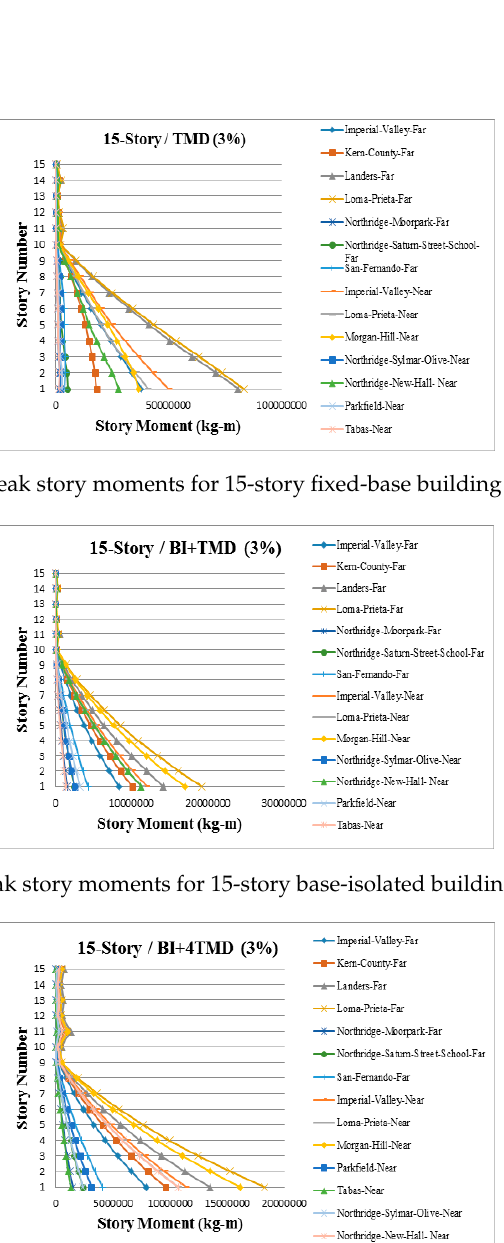
Figure A21. Peak story moments for 15-story base-isolated building with 4 TMDs.